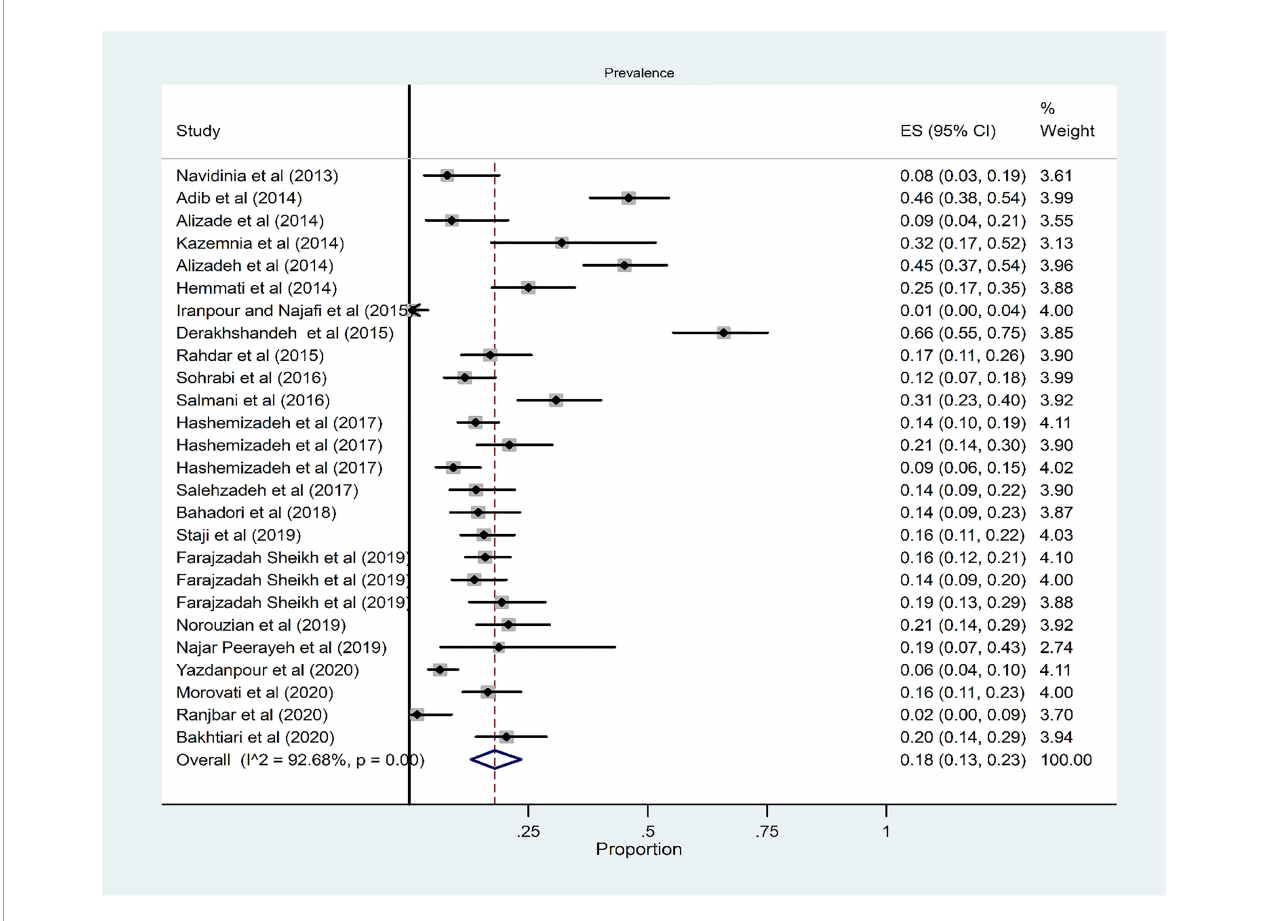
FIGURE 5 | Forest plot of the meta-analysis of phylogroup A prevalence among UPEC